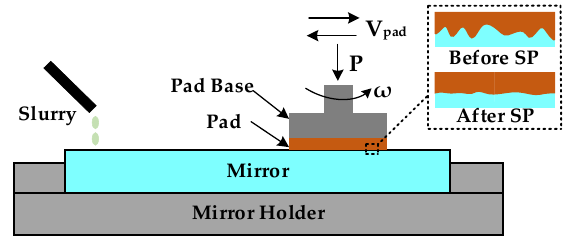
Figure 2. Schematic of the smoothing polishing.